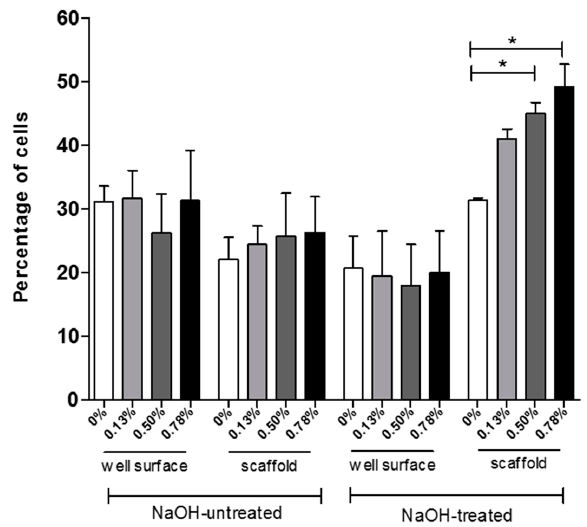
Figure 4. Percentage of cells attached on the well plate surface (cells not attached to the scaffold) and percentage of cells attached on the scaffold after 3 days of cell seeding. * Statistical evidence ( p < 0.05) analysed with a one-way ANOVA and Tukey’s post-hoc test.